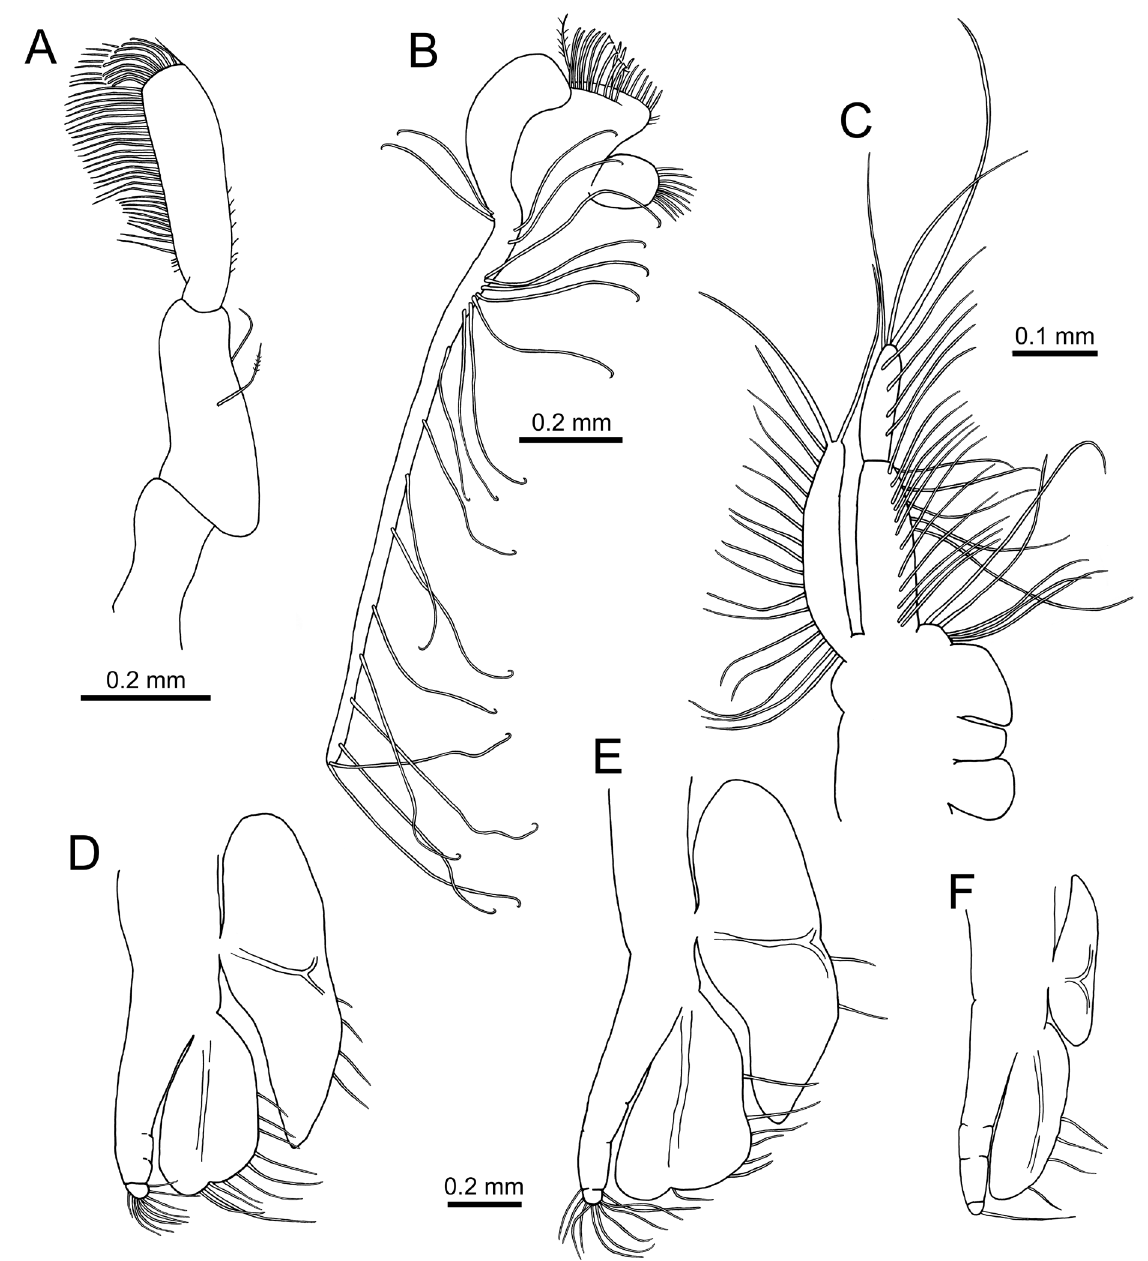
Fig. 3. Nebalia strausi Risso, 1826. Preovigerous female (DBUA0001677.01.W). A . Mandibular palp. B . Maxilla I. C . Maxilla II. D . Thoracopod II. E . Thoracopod V. F . Thoracopod VIII. D–F: same scale bar; C: setules and endites’ setae not illustrated; D–F: only selected setae